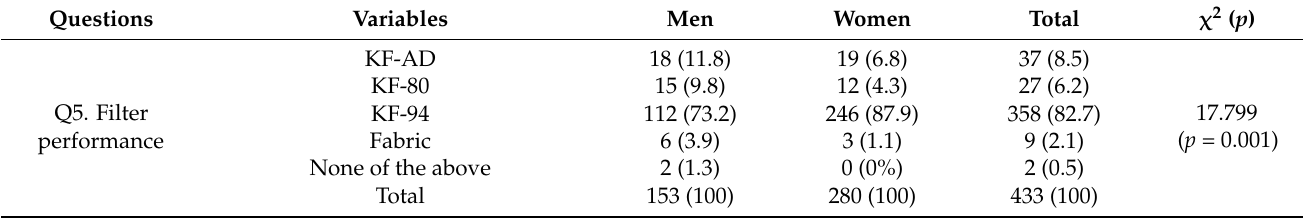
Table 8. Chi-squared test results according to